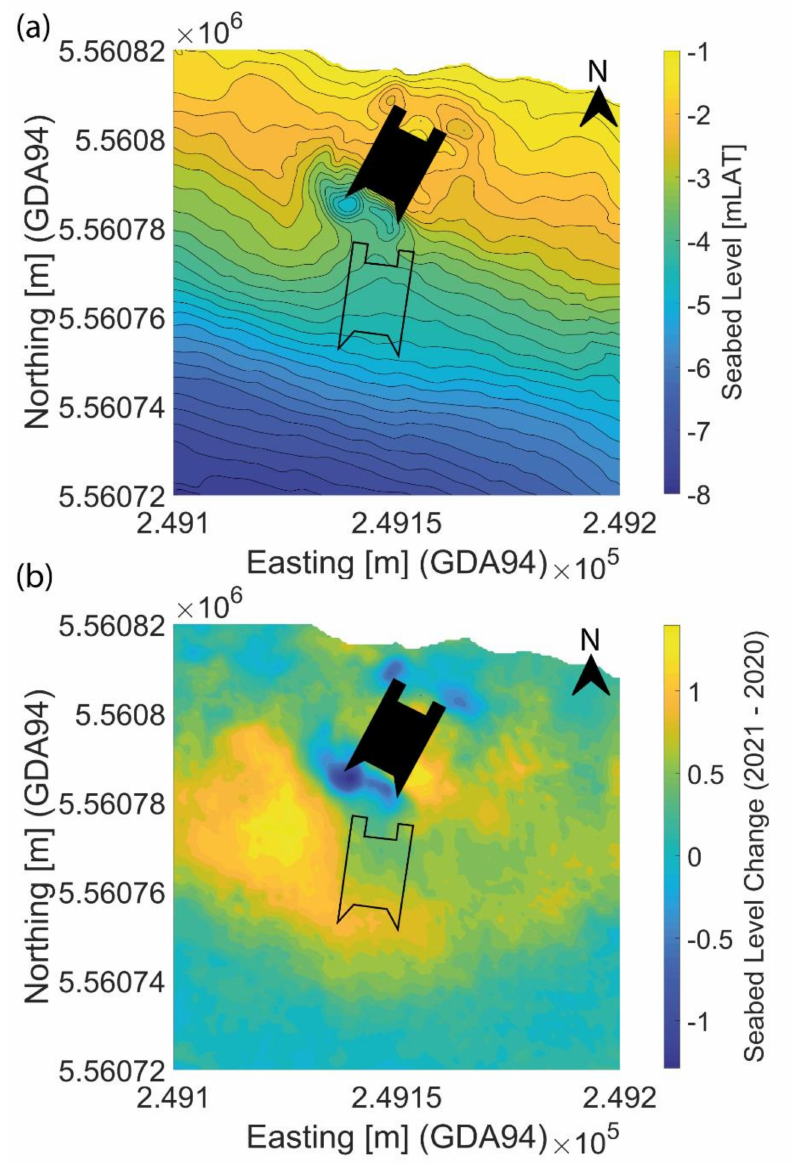
Figure 15. ( a ) Close-up of multi-beam bathymetry measurements on 8 May 2021. ( b ) Elevation changes in the close-up multi-beam bathymetry measured at Grassy on 8 May 2021 relative to the bathymetry measured on 3 December 2020. The black filled plan sketch of the OWC WEC is Location 2, whilst the black outline plan sketch is Location